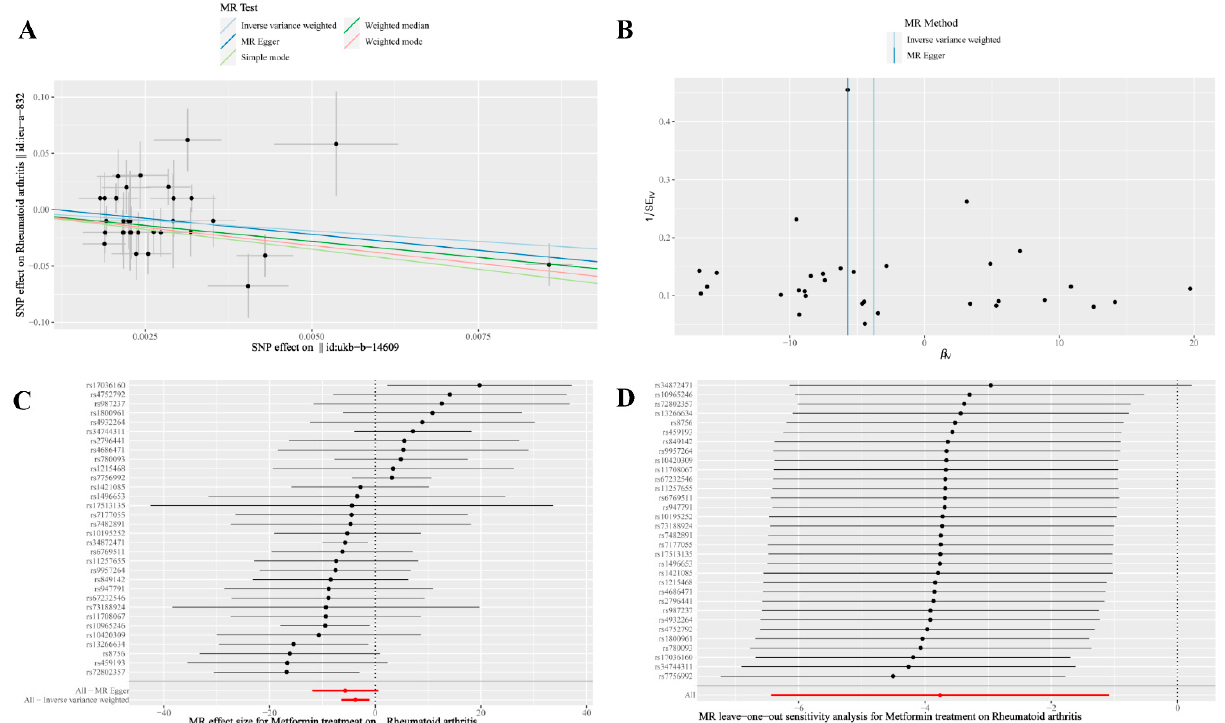
Figure 3. ( A ) Scatter plot of the effects of genetic variants on the metformin treatment and RA. The slopes of the solid lines denote the magnitudes of the associations estimated from the MR analyses. RA, rheumatoid arthritis; MR, Mendelian randomization; SNP, single-nucleotide polymorphism; ( B ) A funnel plot of the causal effect of metformin treatment on RA. RA, rheumatoid arthritis; MR, Mendelian randomization: ( C ) Fixed-effect IVW analysis of the causal association of metformin with RA. The black dots and bars indicate the causal estimate and 95% CI using each SNP. The red dot and bar indicate the overall estimate and 95% CI meta-analyzed by the fixed-effect IVW method. IVW, inverse-variance weighted; RA, rheumatoid arthritis; CI, confidence interval; SNP, single nucleotide polymorphism: ( D ) Leave-one-out analysis plots for metformin treatment on RA. RA, rheumatoid